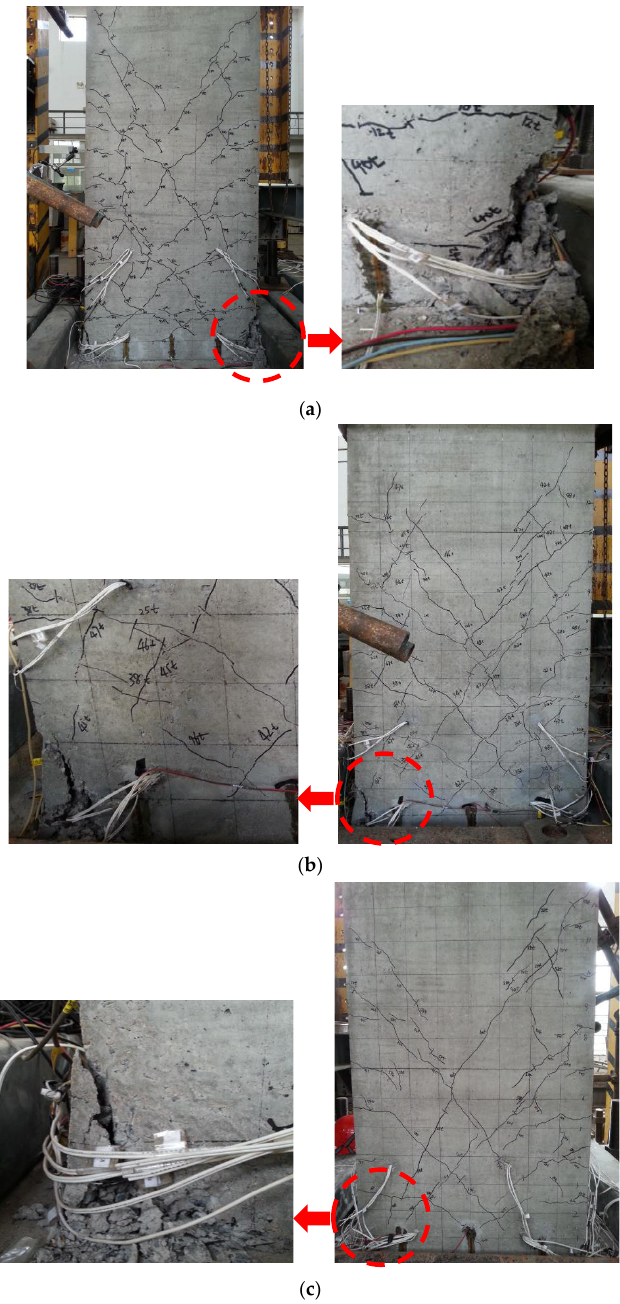
Figure 6. The Distribution of Cracks and the Failure Modes. ( a ) SRCZ-1 and its zoomed figure. ( b ) SRCZ-2 and its zoomed figure. ( c ) SRCZ-3 and its zoomed figure.